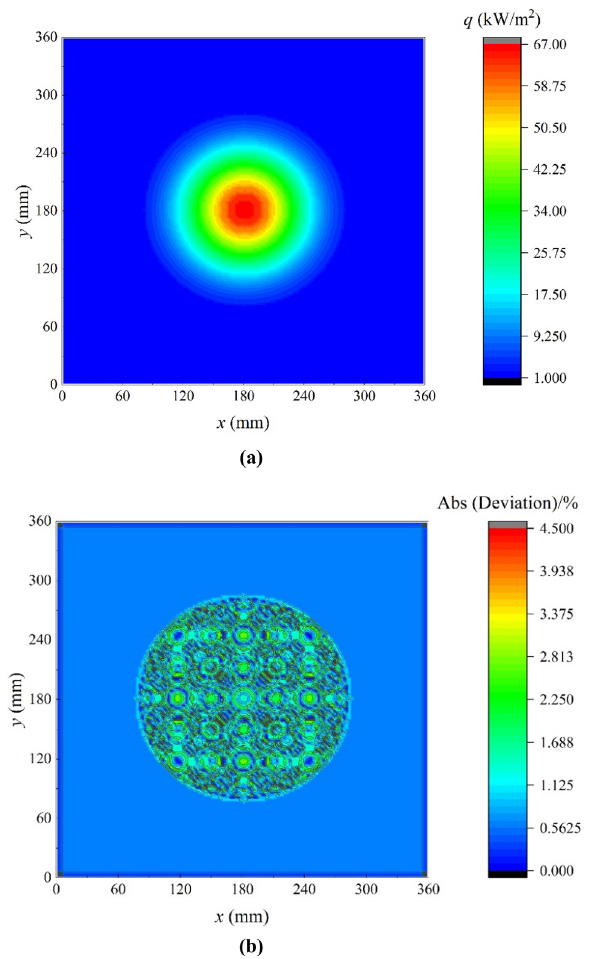
Figure 5. Heat flux distribution and relative deviation. ( a ) Time-average scanned heat flux. ( b ) Relative deviation of time-average scanned heat flux and desired heat flux.